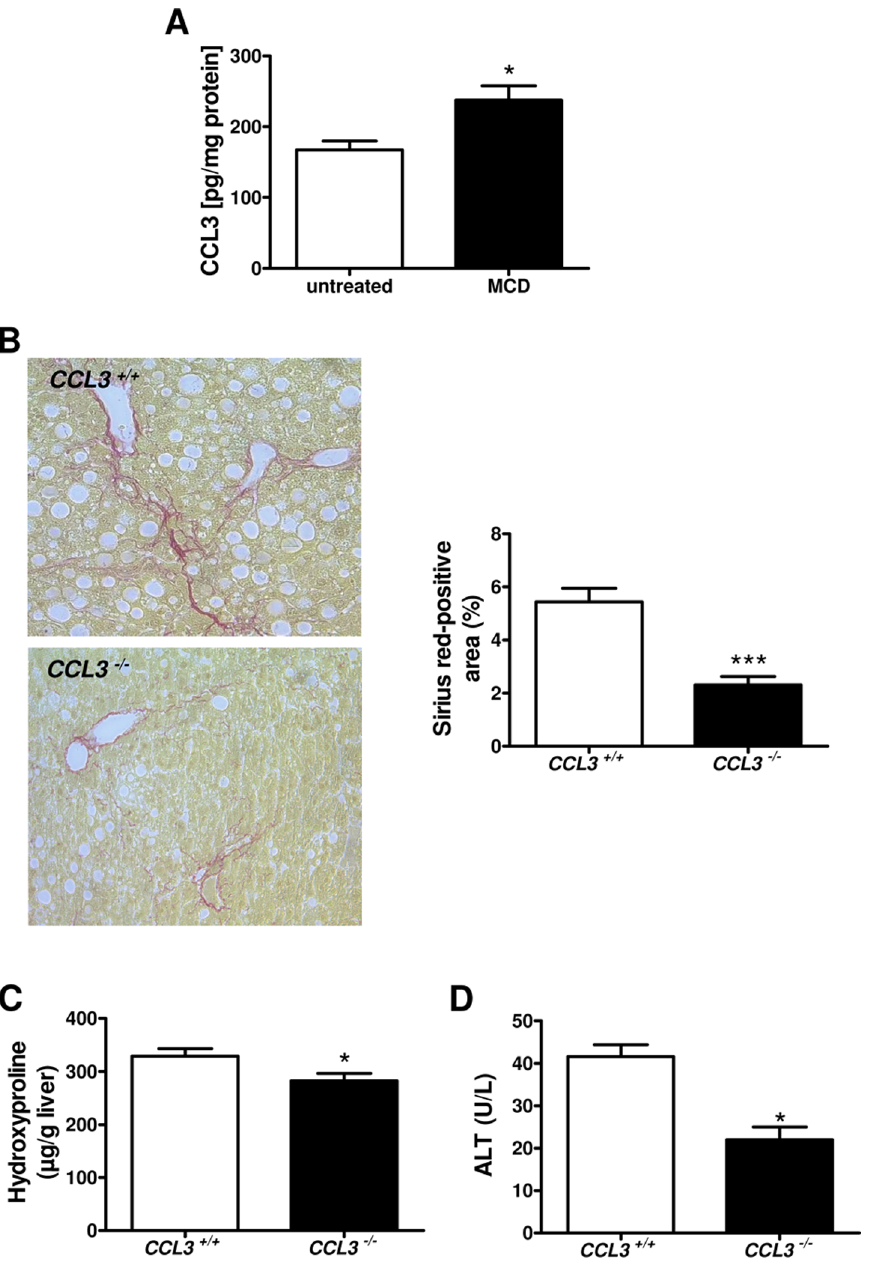
Figure 1. Liver fibrosis in CCL3 2 / 2 mice after eight weeks of MCD diet. CCL3 expression is increased in MCD-fed wild-type mice compared to untreated control ( A ). Representative Sirius red staining of CCL3 2 / 2 and wild-type ( CCL3 + / + ) mice after MCD diet (x100 magnification). Quantitative analysis of the Sirius red-positive area showed a significantly decrease in CCL3 2 / 2 mice compared to wild-type mice ( B ). Hydroxyproline concentration in the liver ( C ) and serum level of ALT ( D ) were also significantly decreased in CCL3 2 / 2 mice. Data are expressed as means 6 SEM of eight mice per group. * P , 0.05, *** P , 0.001.